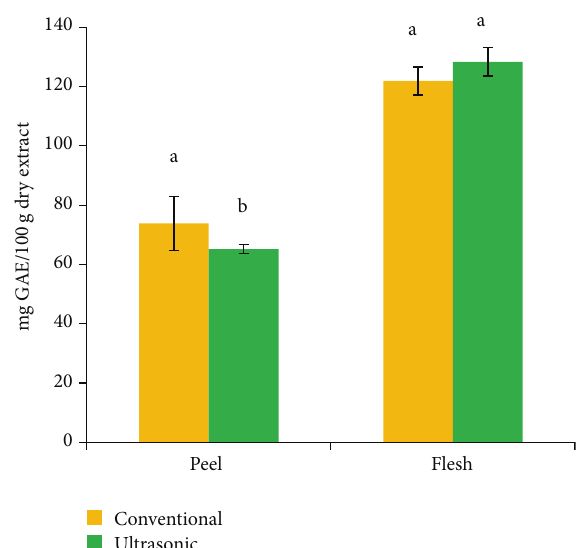
Figure 1: Total phenolic contents extracted from red dragon fruit of different parts by using different methods. (Mean with different alphabets for the same plant parts are significantly different ( 𝑃 < 0.05